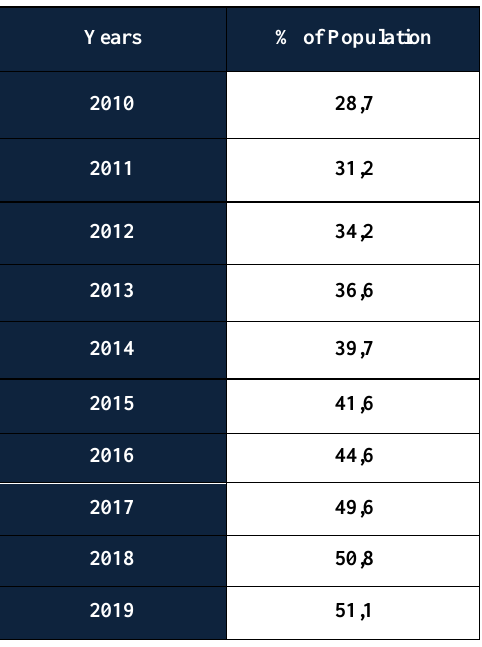
Table 1: Evolution of internet users in the world (% of population)